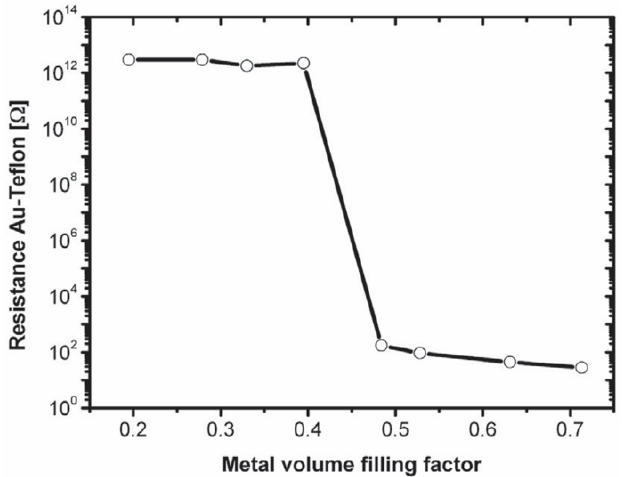
Figure 23. Change of electrical resistance with increasing filling factor of Au-TAF nanocomposites. (Reproduced with permission from [52], Copyright Cambridge University Press